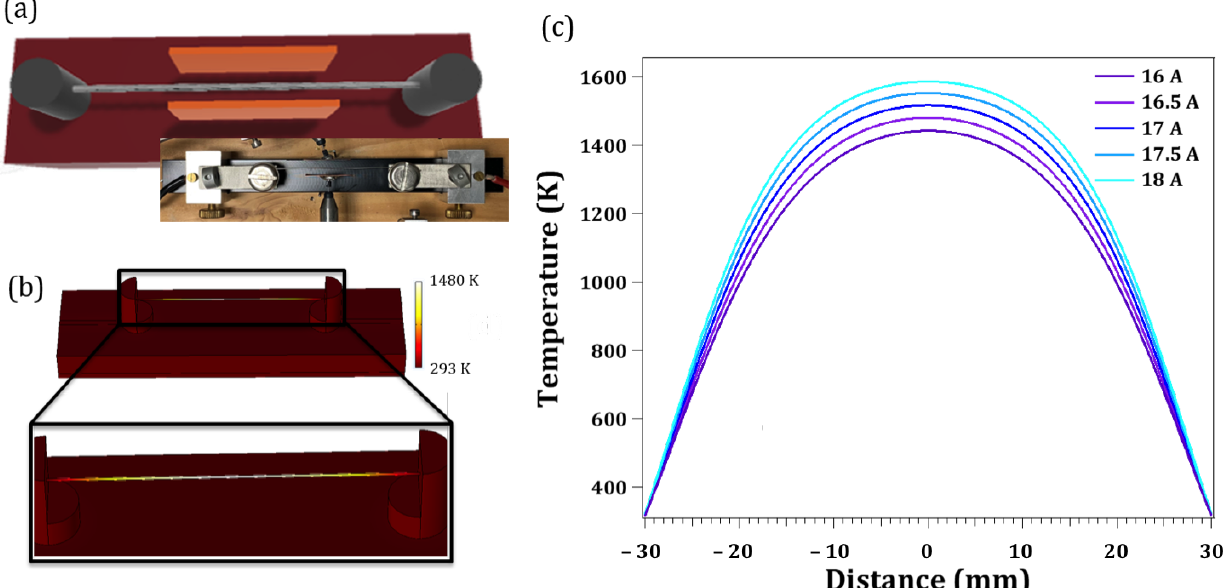
Figure 1. ( a ) Sketch of the setup (top view) for the resistive heating experiments. ( b ) Results of the tem- perature of the system simulated by COMSOL for 16.5 A current through the wire. ( c ) Temperature profiles along the W wire for several electrical